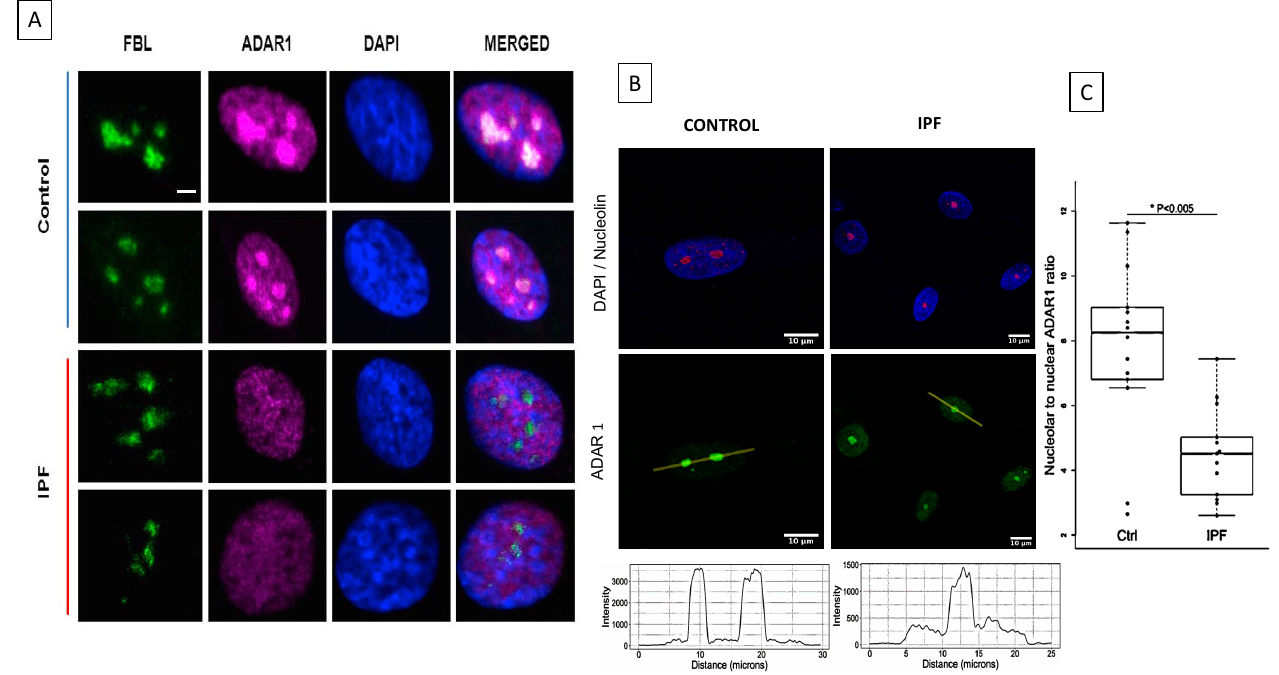
Figure 2. Immunolocalization of ADAR1 in the nucleus on control and fibrotic pulmonary fibroblasts. ( A ) Fibrillarin (FBL, green; lane 1) was used as a specific marker for the nucleolus. ADAR1 was observed in magenta color (lane 2). Nuclei-stained with DAPI (lane 3). In control fibroblasts, ADAR1 is in the nucleolus and nucleoplasm (lane 2), whereas in fibrotic fibroblasts, the distribution